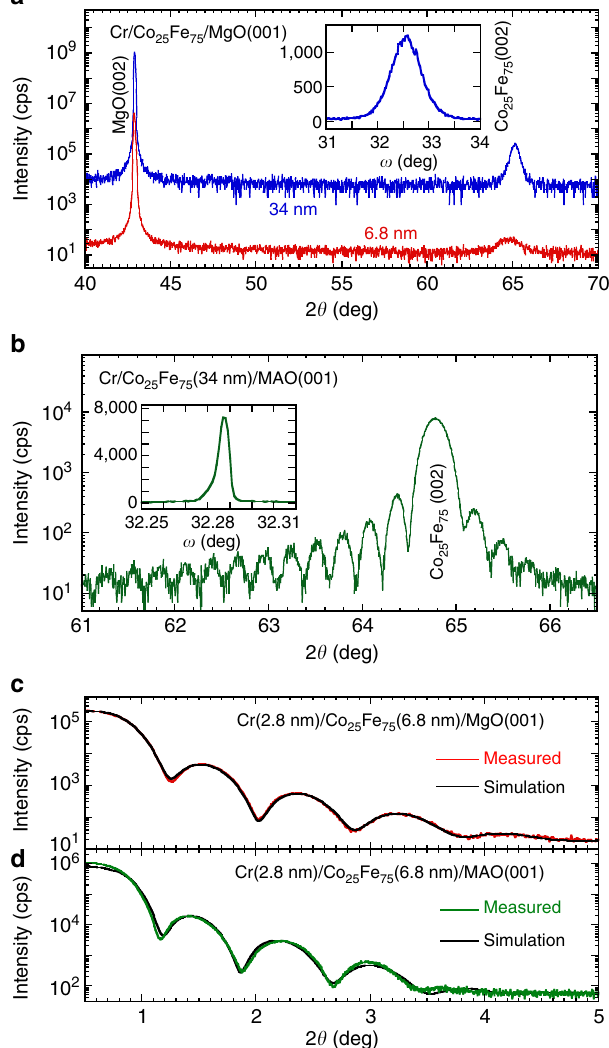
Fig. 1 X-ray diffractometry and re fl ectometry of Co 25 Fe 75 fi lms on MgO and MgAl 2 O 4 (MAO). a 2 θ − ω X-ray diffraction (XRD) scans